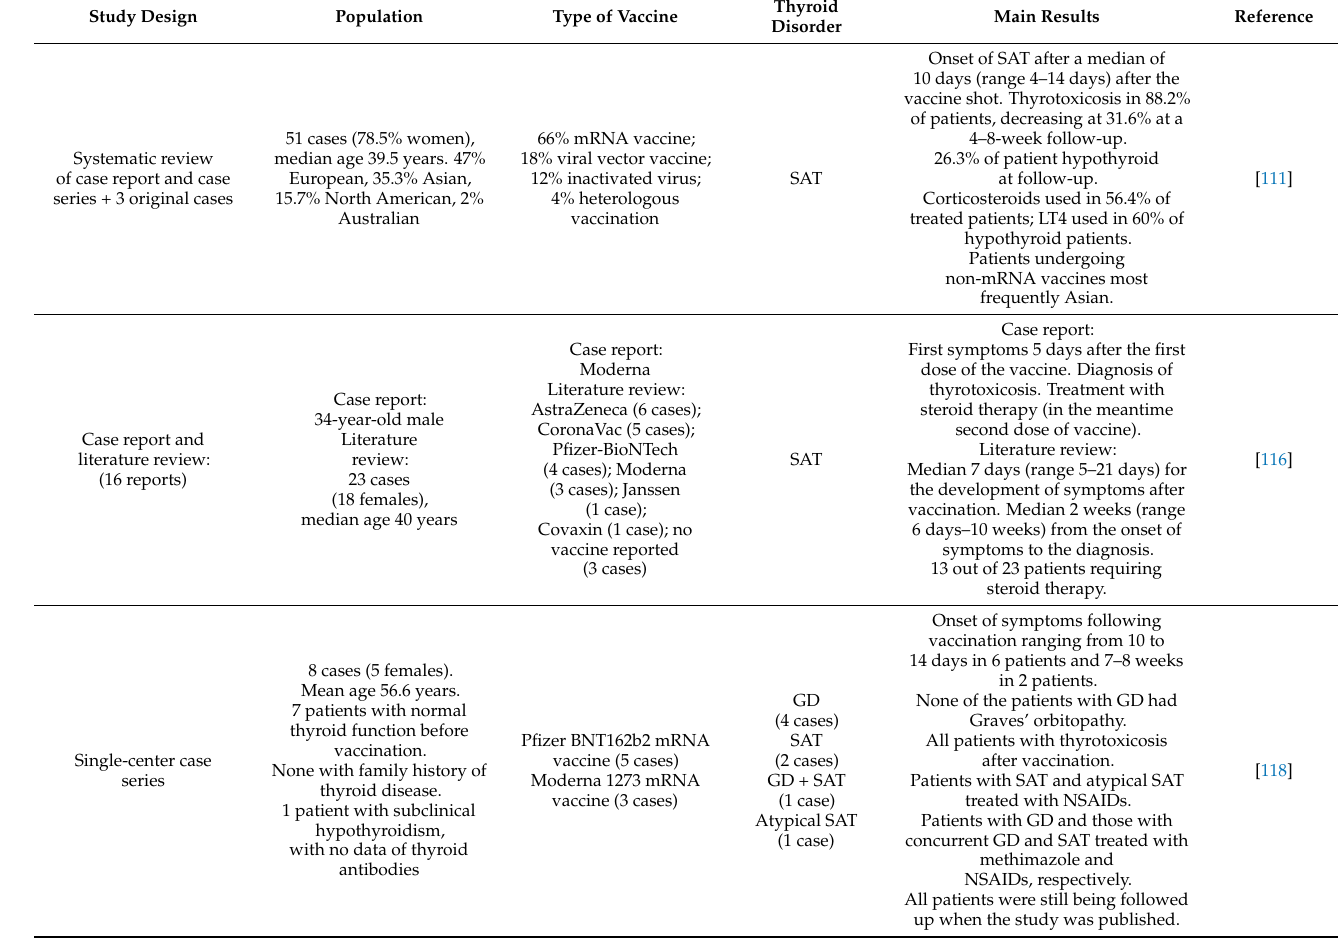
Table 3. Summary of findings on the relationship between SARS-CoV-2 vaccination and thyroid